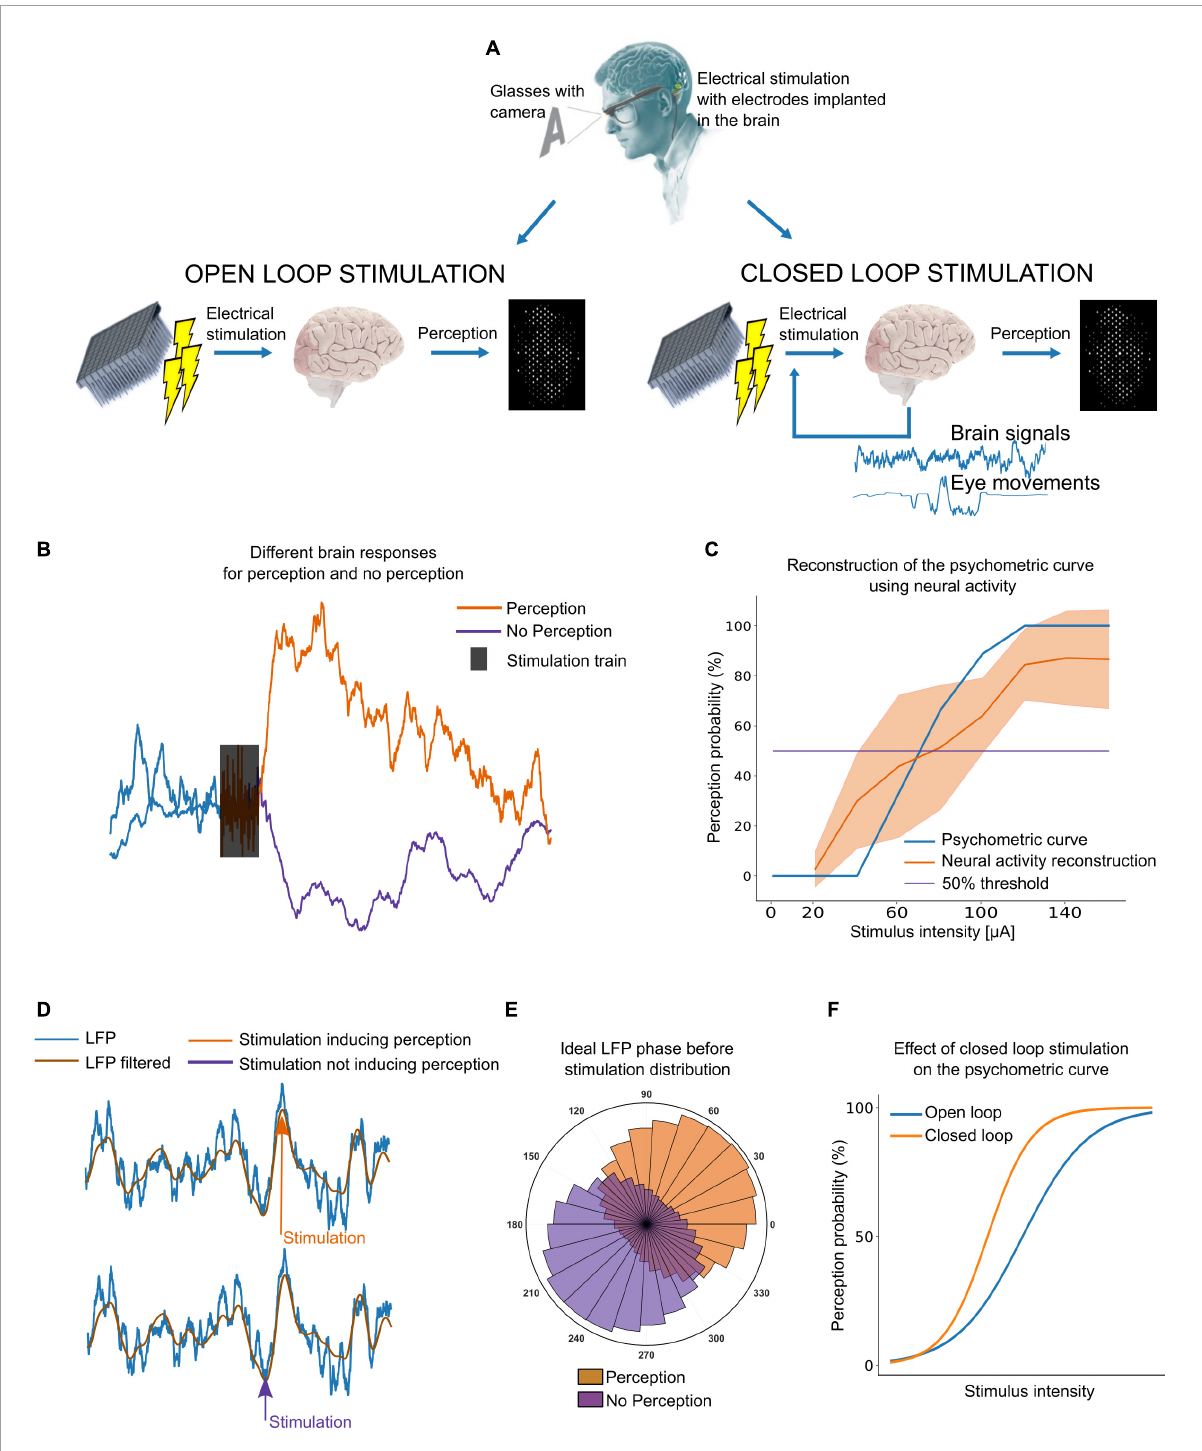
FIGURE1 Closed-loop stimulation of the visual cortex. (A) Diagram of open-loop versus closed-loop stimulation approaches. (B) Example of intracortical brain signals. A clear difference between perception and no perception is needed to adjust the current to induce perception without the user’s feedback. (C) Example of a psychometric curve obtained with user’s feedback (blue) and neural signals (orange). (D) Local field potentials (LFP) phase dependent response to stimulation. Inducing perception might be easier by stimulating the right LFP phase. (E) Ideally, the distribution of LFP phase should be different for perception and no perception. (F) Stimulating at the right LFP phase, we could decrease the charge required to reliably evoke